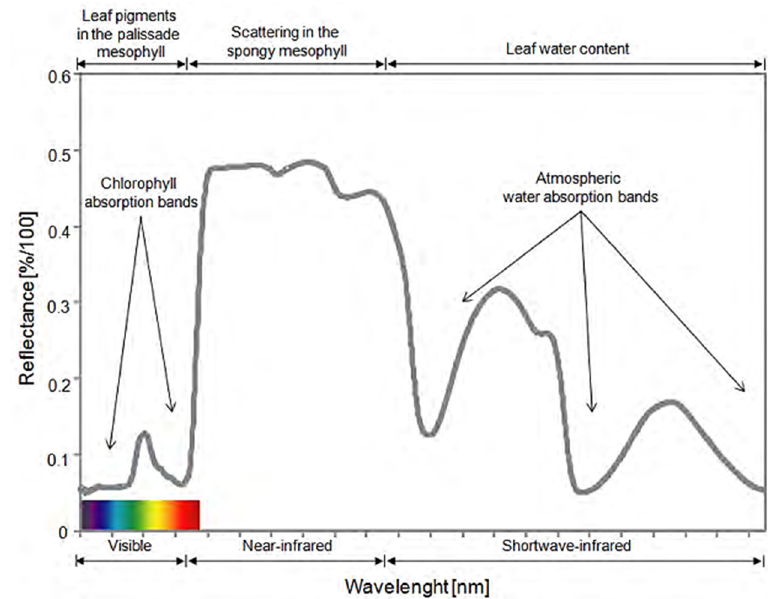
Figure 1. Spectral signature of healthy vegetation